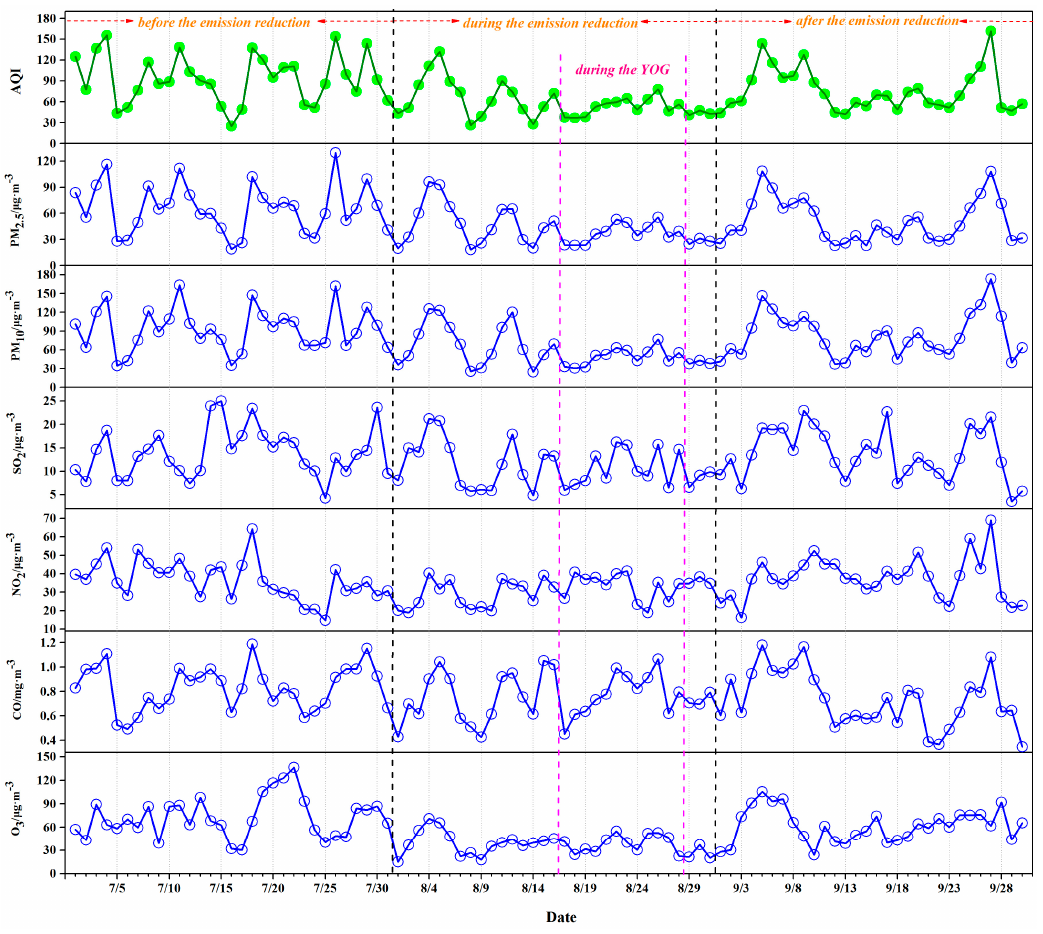
Fig ure 2. Daily variation of the AQI and air pollutant concentrations in different periods. Figure 2. Daily variation of the AQI and air pollutant concentrations in different